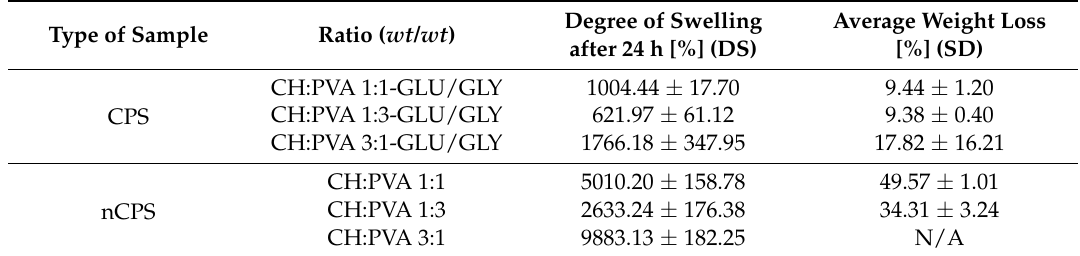
Table 1. Degree of swelling and solubility degree for CPS and